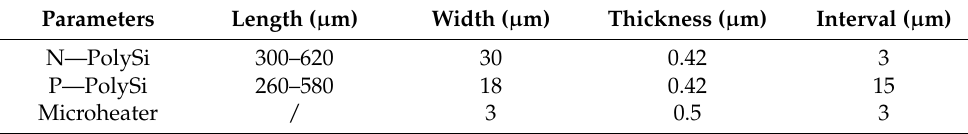
Table 1. Key structural parameters of the